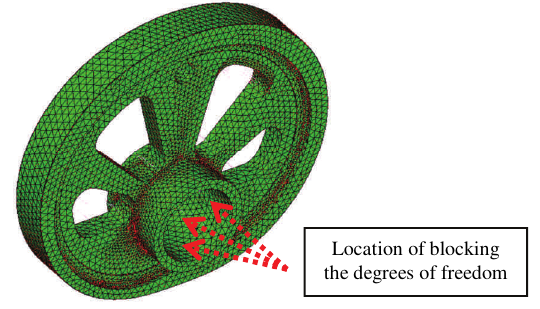
Fig. 10. Computational model of the